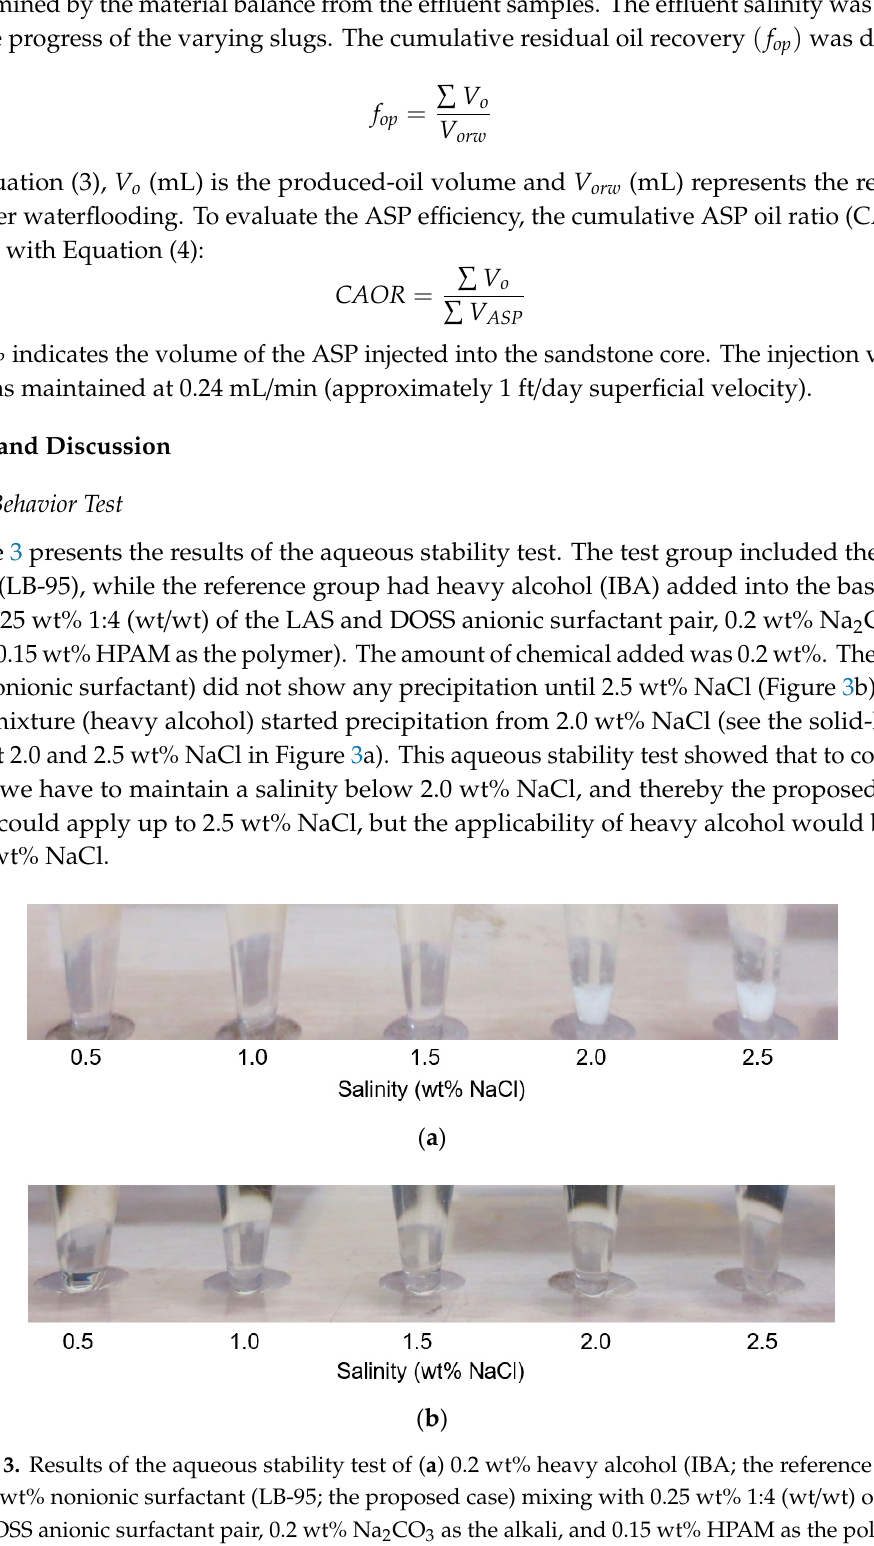
Figure 2. Schematic diagram of the experimental apparatus for the coreflooding test. ‘ASP’ stands for